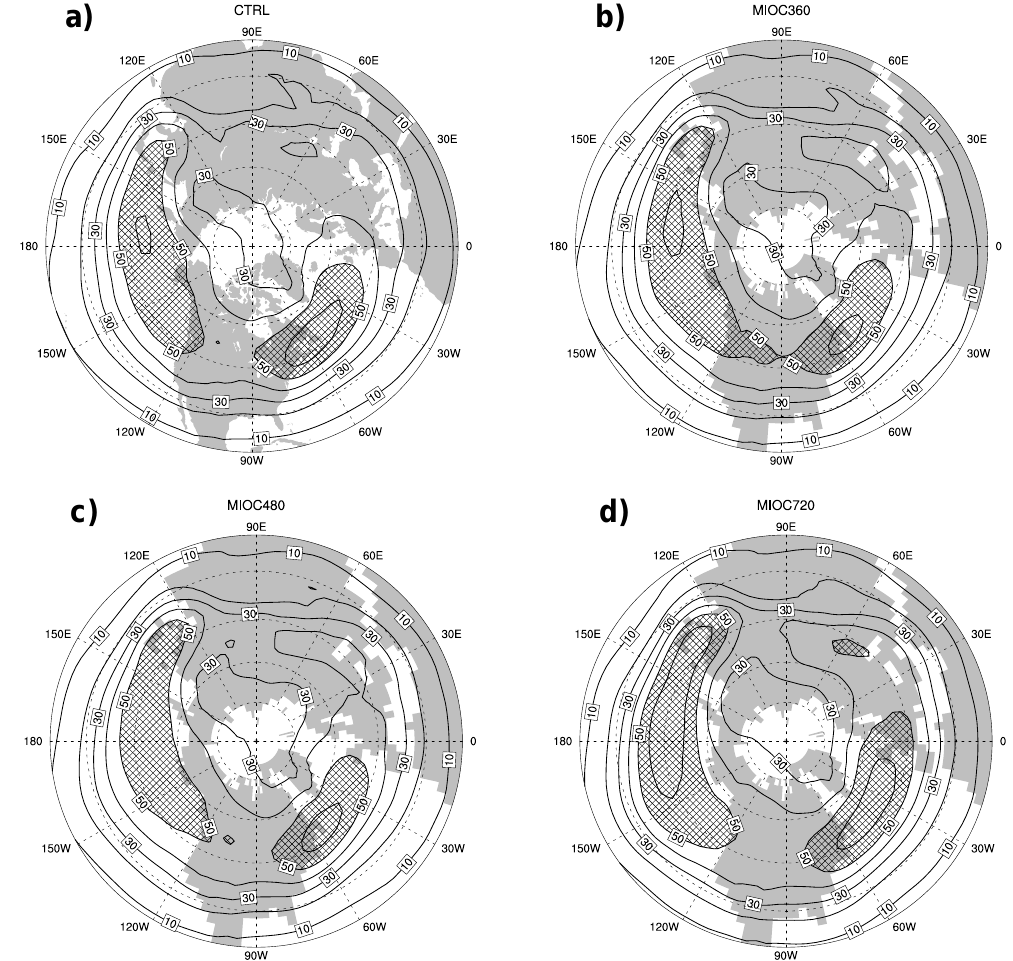
Fig. 8. Winter storm tracks defined as deviations of the 2–6 days bandpass-filtered 500hPa geopotential height from December to March for (a) CTRL, (b) MIOC360, (c) MIOC480, and (d) MIOC720 (in gpm). Contour interval is every 10gpm. Stippled regions indicate mean deviations that are larger than